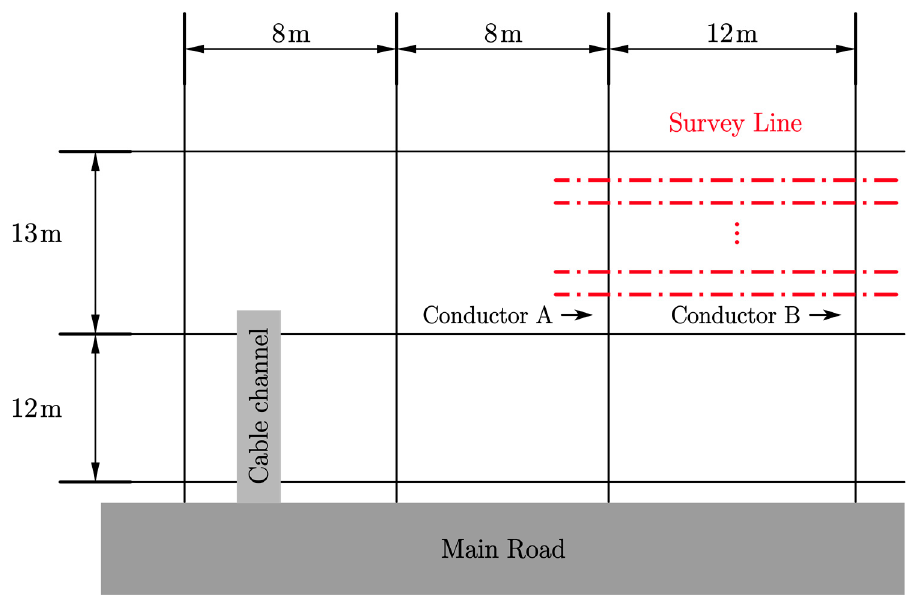
Figure 10. Schematic diagram of survey lines and topology.